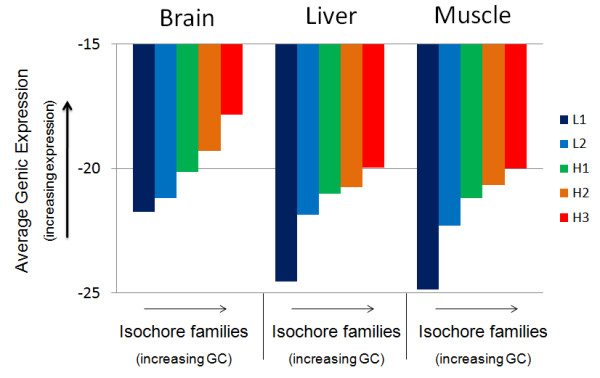
Average genic activity within each isochore for the three tissues. Average genic expression levels after the genes have been binned in the five isochore families. Larger negative values (tall coloured bars) indicate low expression, and small negative values (short coloured bars) indicate high expression.